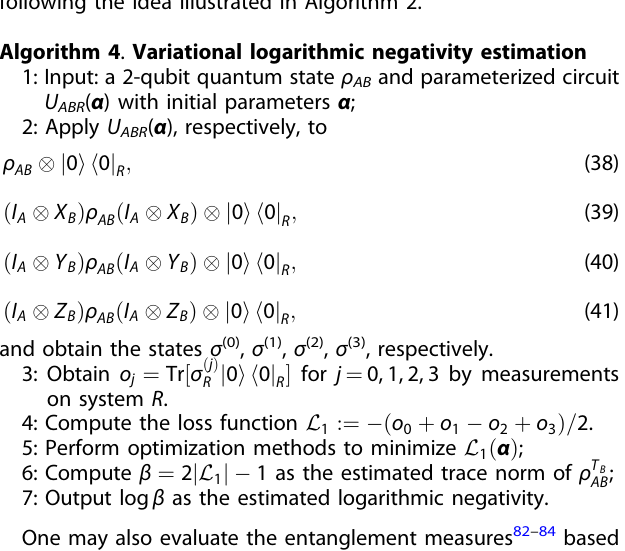
Fig. 3 Comparison between VED and improved VED on estimate accuracy. The overlap 0 h jR B ! B ð ρ AB Þ 0 j i is estimated using the reduction map's Pauli decomposition (Equation (26) used in VED) and its simple structure (Eq. (33) in the improved VED), where ρ AB is the four-qubit generalized W state. The methods are simulated under fi ve different numbers of measurement shots, and for each given number of shots, they are, respectively, repeated 50 times. The distributions of both methods' estimations are summarized in box plots, where each box extends from the fi rst quartile to the third quartile of the corresponding data, with a line at the median. The whiskers extend to the most extreme data points within 1.5 times the interquartile range. The red horizontal line gives the theoretical value for reference. The improved VED (cf. Algorithm 3) achieves a better